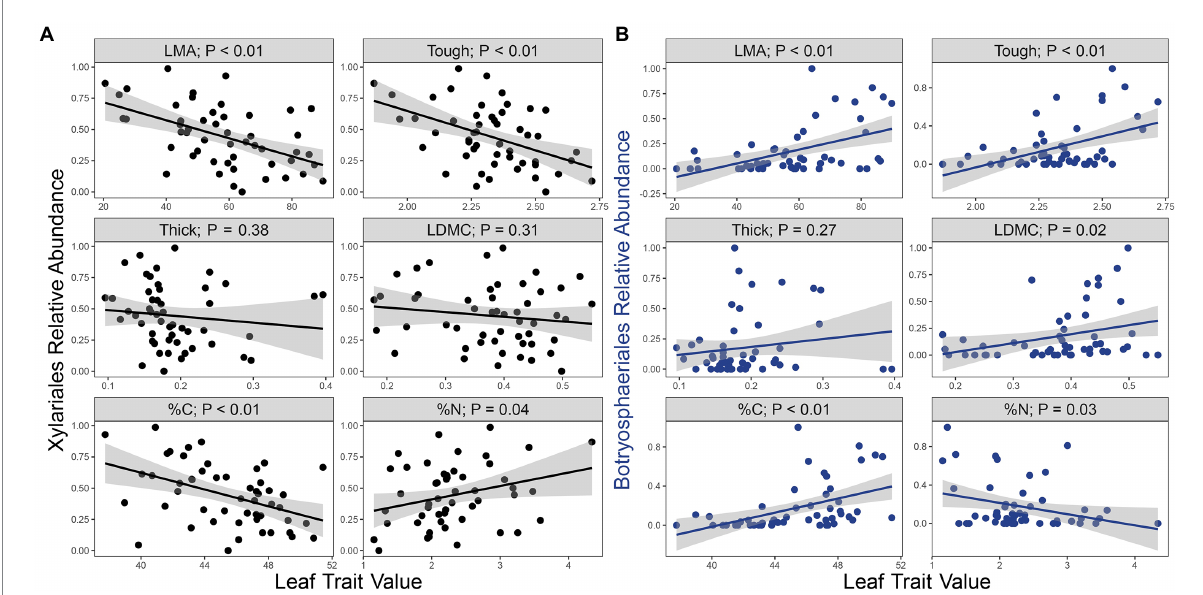
FIGURE 3 The two most common fungal orders showed contrasting relationships with leaf functional traits. Associations between the relative abundance of fungal orders (A) Xylariales (Sordariomycetes) and (B) Botryosphaeriales (Dothideomycetes) to leaf mass per area (LMA, g m − 2 ), and leaf punch strength (“Tough,” log N mm − 1 ), leaf thickness (Thick, log μ m), leaf dry matter content (LDMC, g g − 1 ), leaf carbon (%C, log %), and leaf nitrogen (%N, log %). Grey bands represent the SEs of the regression lines. Analyses are from the culture-based survey ( n =